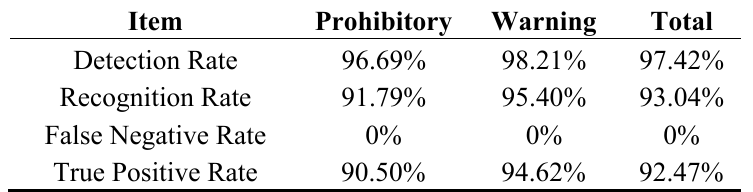
Table 6. The experimental results of detection and recognition for static images.